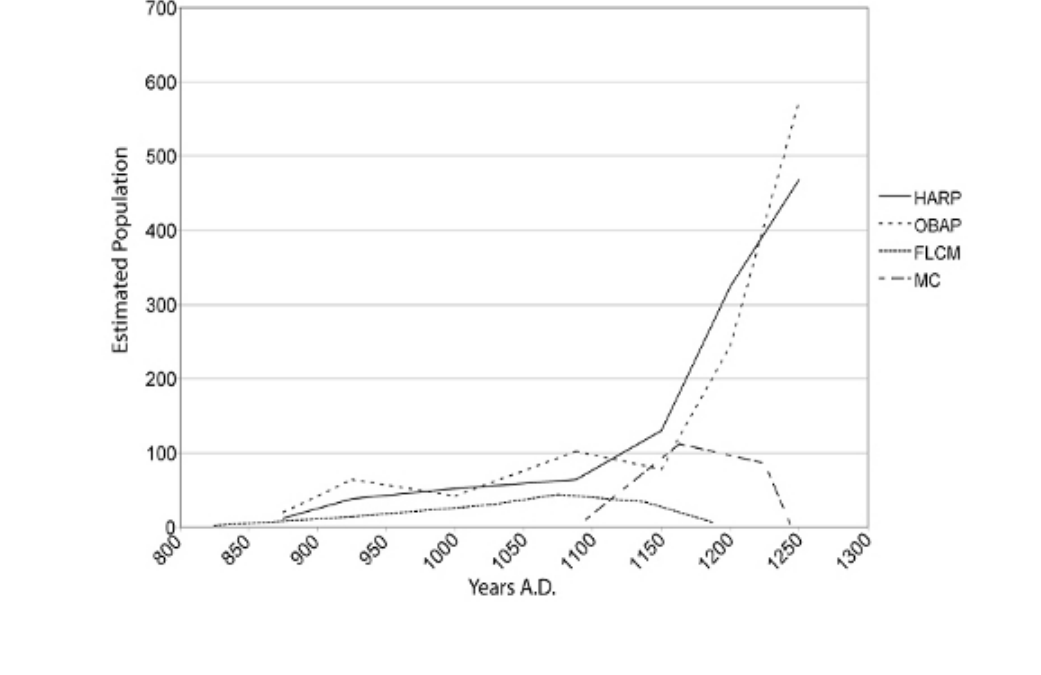
Fig. 7. Change over time in estimated population size in the Zuni region. Population estimates for the Zuni case were not calculated for the region as a whole. Instead, four large full-coverage survey areas were used to illustrate the magnitude of changes occurring through time in specific places. These surveys consist of the Heshotauthla Archaeological Research Project (Kintigh et al. 2004), the Ojo Bonito Archaeology Project (Kintigh 2007), the Fence Lake Coal Mine Survey (Hogan 1985), and the Miller Canyon Archaeological Survey (Kintigh 1980). Sites were placed into temporal categories using the proportions of well-dated ceramic complexes (following Kintigh et al. 2004). Room counts assigned to each temporal interval were converted into population estimates, assuming two people per masonry room. Population estimates were then adjusted to account for the length of each interval, assuming a site-use life of approximately 25